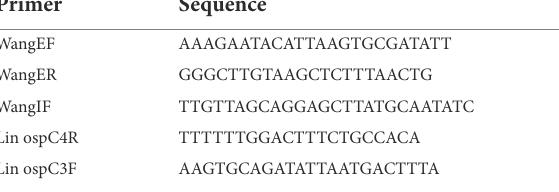
TABLE 1 PCR primers and